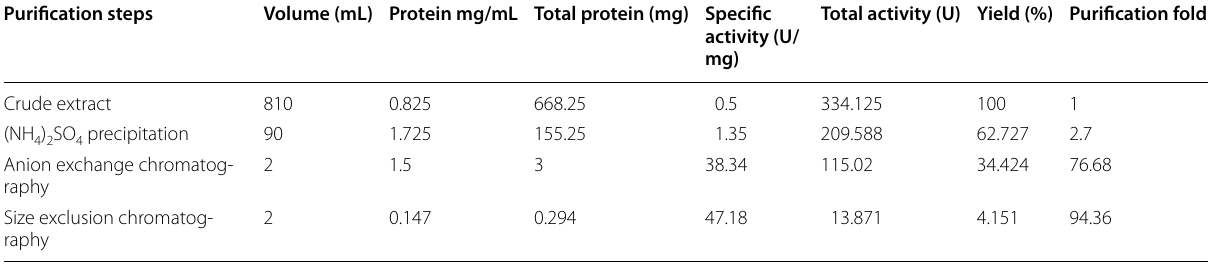
Table 1 Summary of sequential purification of periplasmic L-ASNase from Pseudomonas sp.